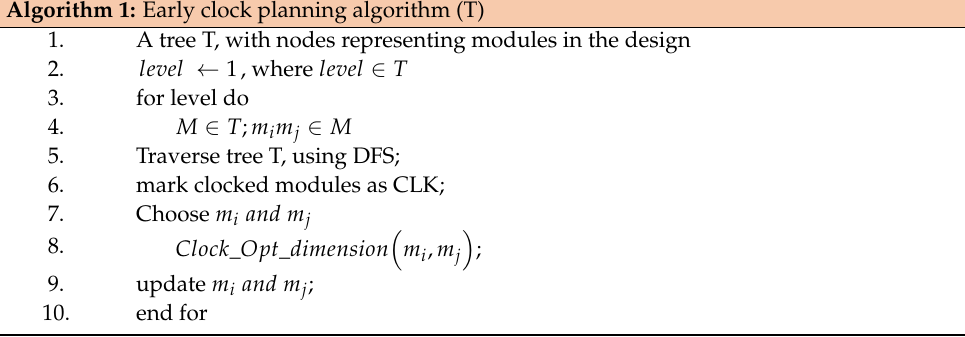
Algorithm 1: Early clock planning algorithm